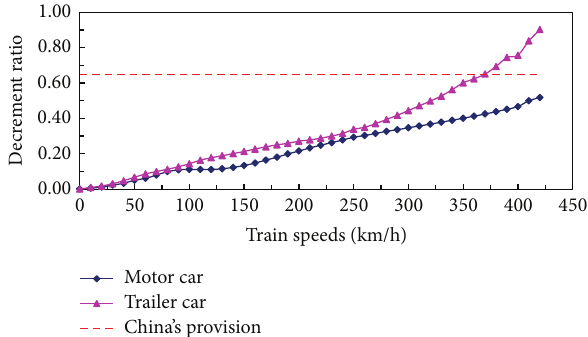
Figure 28: Maximum wheel load decrement ratio under various train speeds.